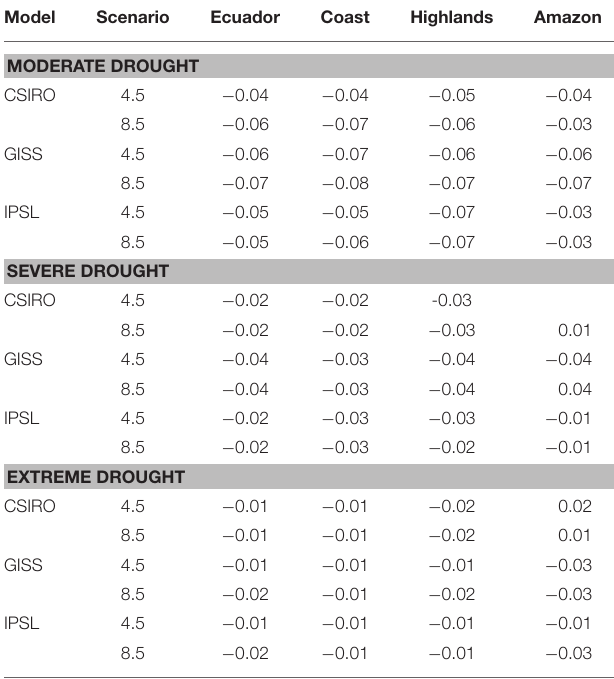
TABLE 4 | Change of drought probabilities.